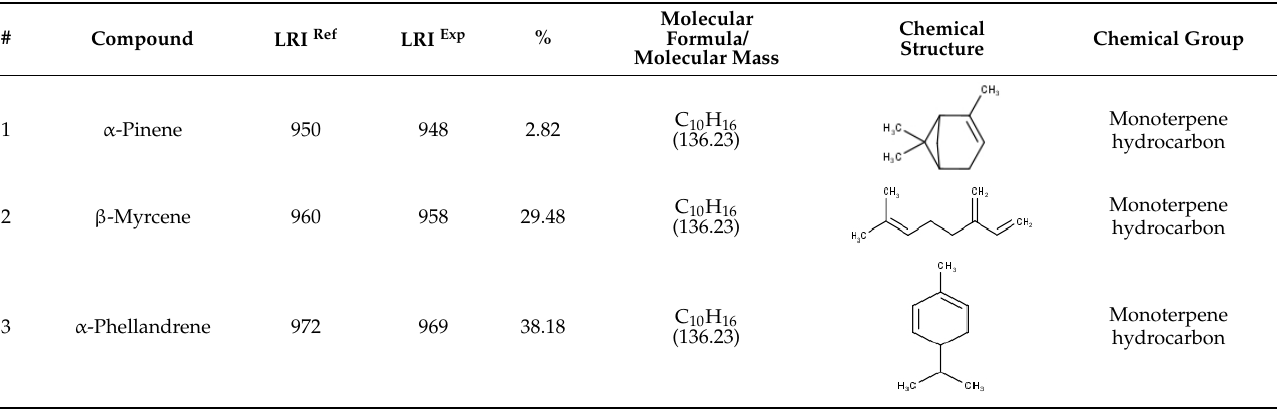
Table 1. Chemical composition of the essential oil of P. acutifolium. % is the relative percentage of each compound based on a mean of 3 determinations. LRI Ref is the linear retention index obtained from database [24]; LRI Exp is the linear retention index calculated against n-alkanes C9–C24.